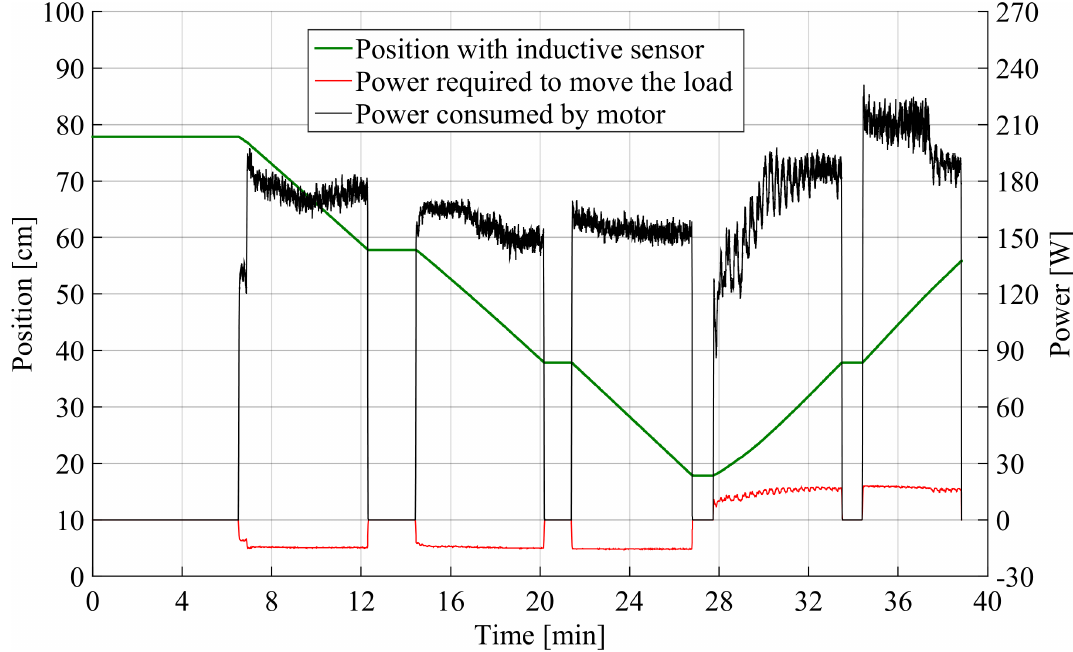
figure. The power consumption during the last adjustment was more constant, with an average value around 210 W.